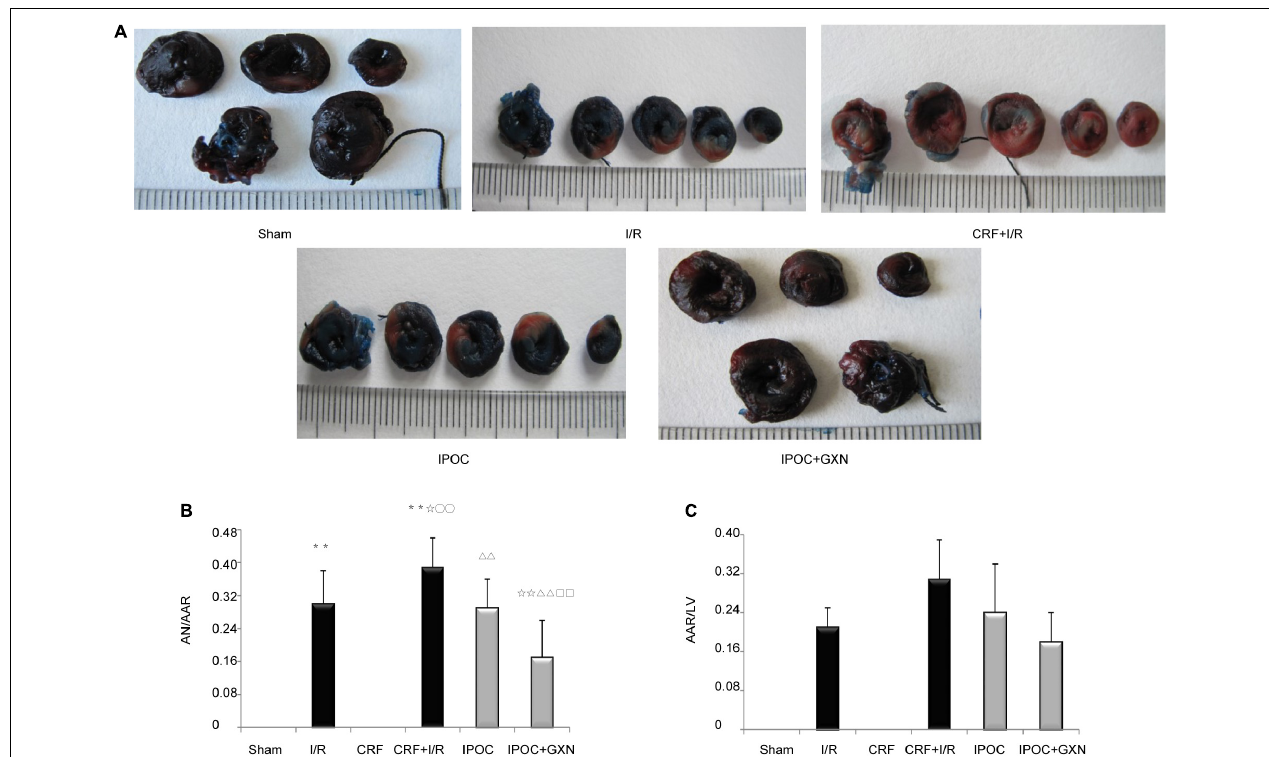
FIGURE 4 | Myocardial ischemia and infarct area. (A) Myocardial infarction area assessed by Evans blue and Triphenyl tetrazolium chloride staining; (B) AN/AAR; (C) AAR/LV. Compared with Sham group, ** P < 0.01. Compared with the I/R group, (cid:73) P < 0.05, (cid:73)(cid:73) P < 0.01. Compared with CRF group, (cid:13)(cid:13) P < 0.01. Compared with CRF+IR group, (cid:49)(cid:49) P < 0.01. Compared with IPOC group, (cid:3)(cid:3) P <